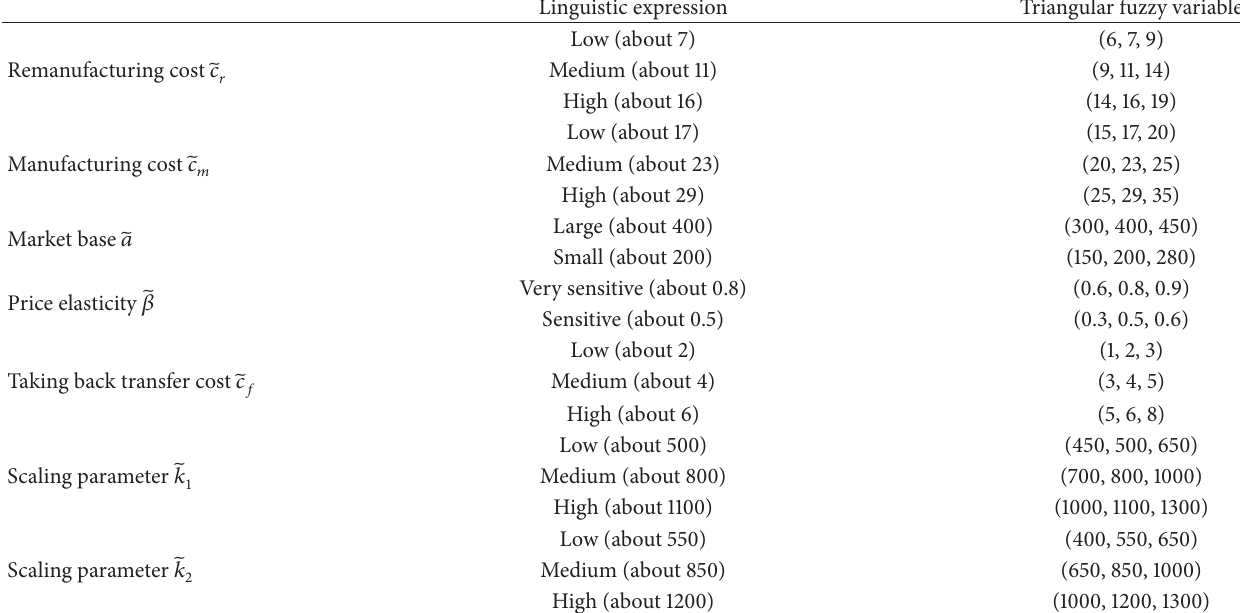
Table 1: Relation between linguistic expression and triangular fuzzy variable.